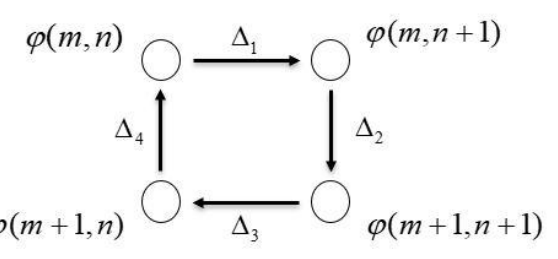
Figure 2. The RP calculation schematic.